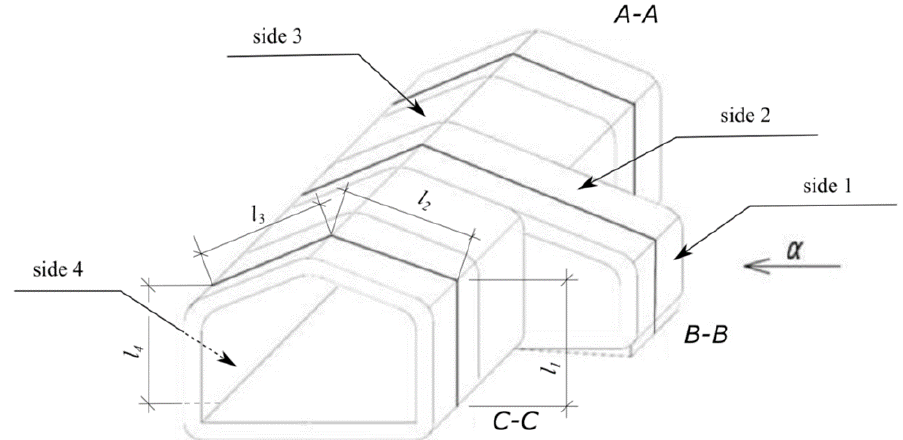
Figure 2. Characteristic cross sections A-A, B-B and C-C for conducting experimental studies on the model in the direction of the oncoming wind flow α = 0°.